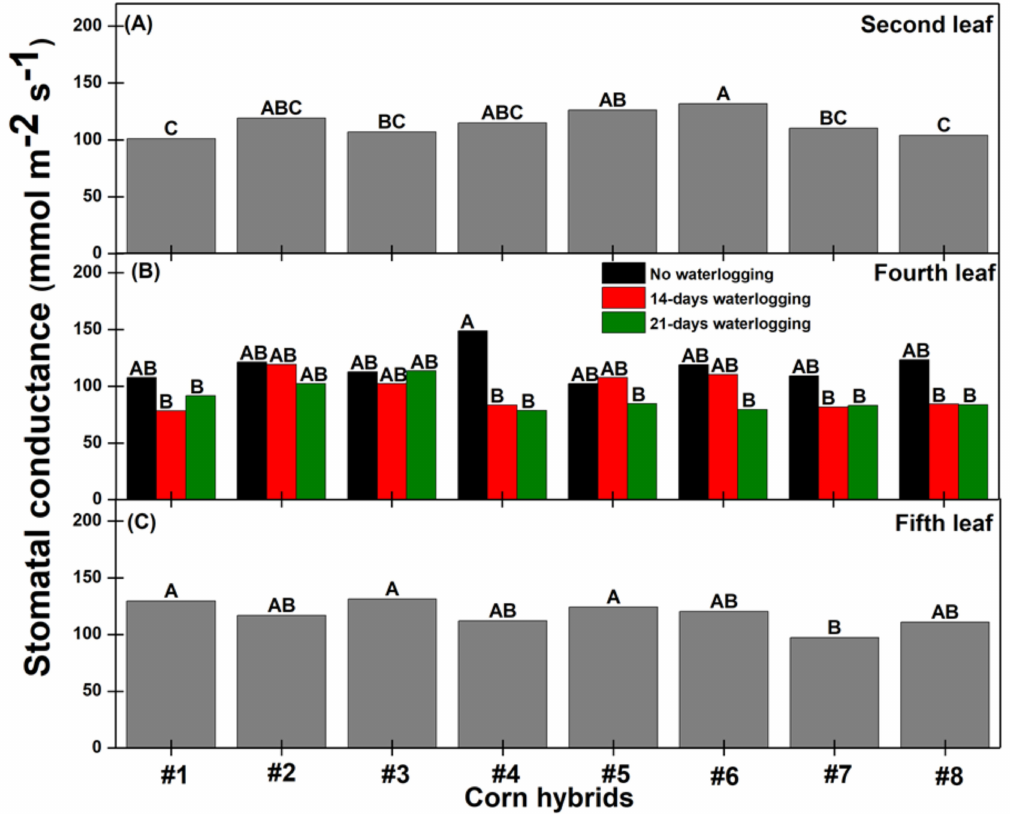
Figure 3. Stomatal conductance of the second ( A ), fourth ( B ), and fifth ( C ) leaves of corn plants among different hybrids. Same letters on bars indicate means do not differ significantly ( p < 0.10) based on Fisher’s least significant difference test. Means are compared separately for each leaf. Data was averaged over waterlogging duration for second and fifth leaves due to absence of significant effect of waterlogging duration and interaction between hybrids as well as no significant effect of waterlogging duration on stomatal